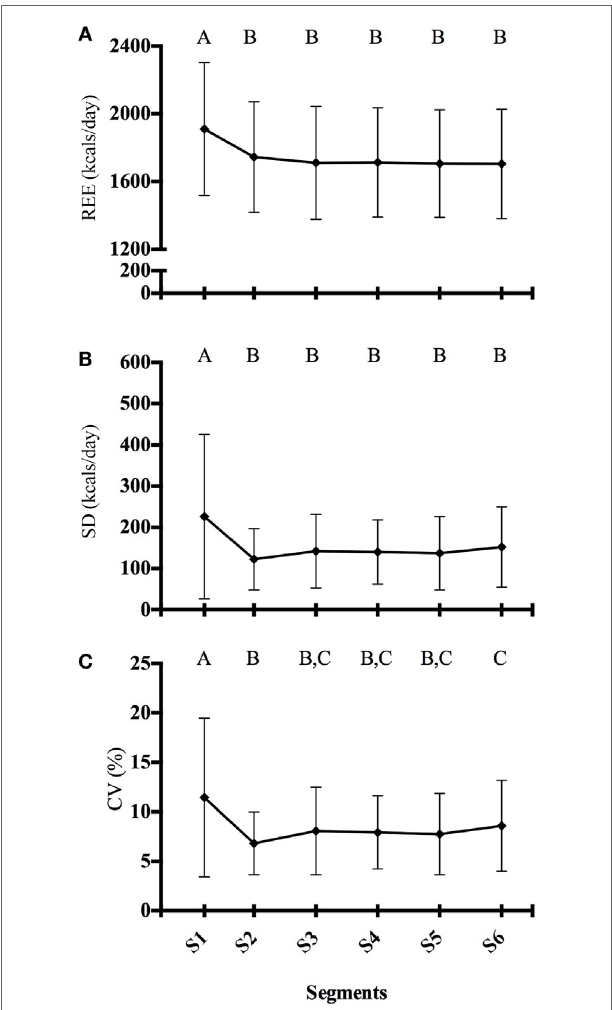
FIgURe 1 | Resting energy expenditure, sd, and percent coefficient of variation . (A) REE, (B) SD, and (C) %CV. All variables are plotted over six 5-min segments (i.e., S1, S2, S3, etc.) Data represent mean ± SD. Means with different letters are statistical different ( P < 0.05).